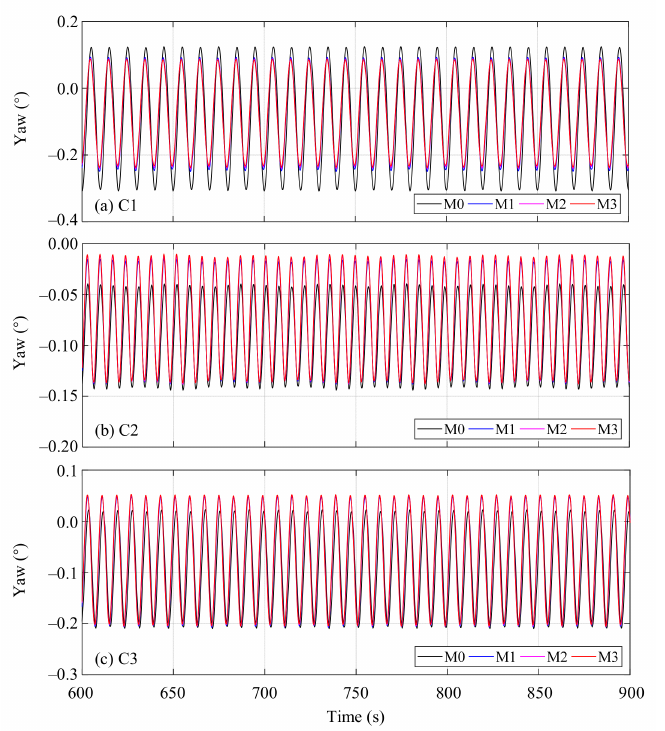
Figure 10. Wind turbine yaw movement time series with M0–3 when under: ( a ) C1; ( b ) C2; ( c )